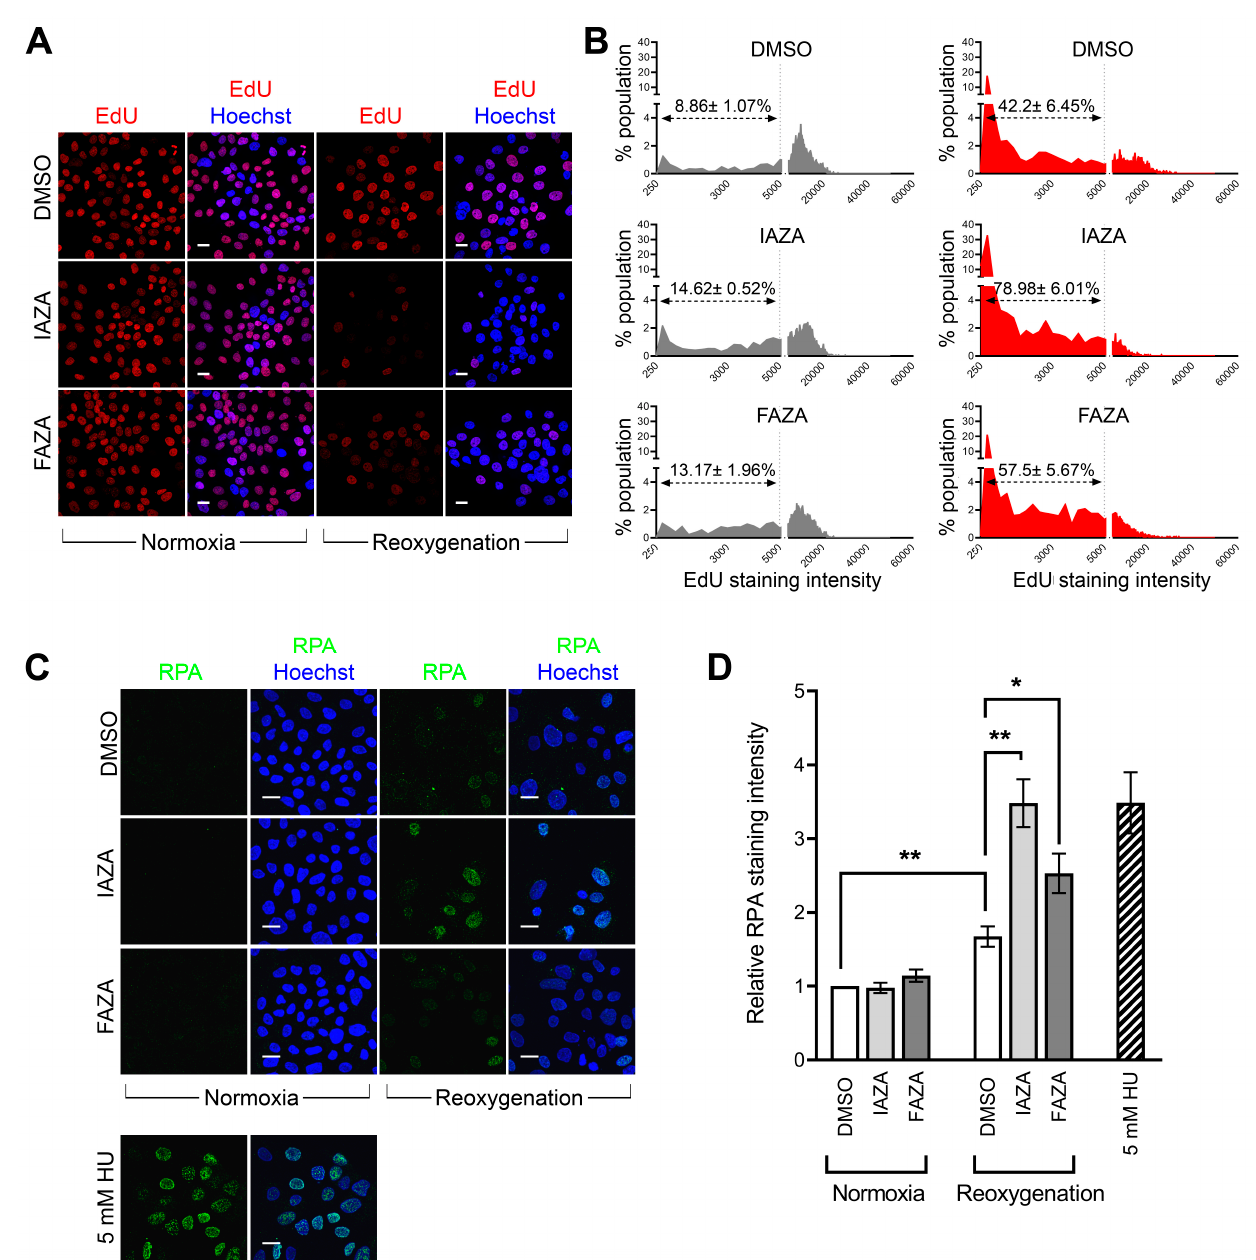
Figure 4. IAZA-/FAZA-treated hypoxic cells display signs of replication stress upon reoxygenation. ( A ) Representative micrographs showing click-EdU incorporation rates in FaDu cells treated with vehicle control (DMSO) or drugs (IAZA or FAZA; 100 µ M) under normoxia and hypoxia (<0.1% O 2 ), followed by a 24 h reoxygenation and recovery period. ( B ) Intensity of EdU click-stained micrographs was quantified and plotted as intensity versus %population histograms. Hypoxic exposure by itself increased cell population with low EdU staining; incubation with IAZA and FAZA under hypoxia further increased “low EdU stained” cell fractions. ( C ) Drug-treated reoxygenated cells showed higher levels of detergent extraction resistant chromatin-bound RPA. ( D ) Quantification of nuclear RPA staining. Data show mean ± S.E.M. from three independent replicates; scale bar = 20 µm.